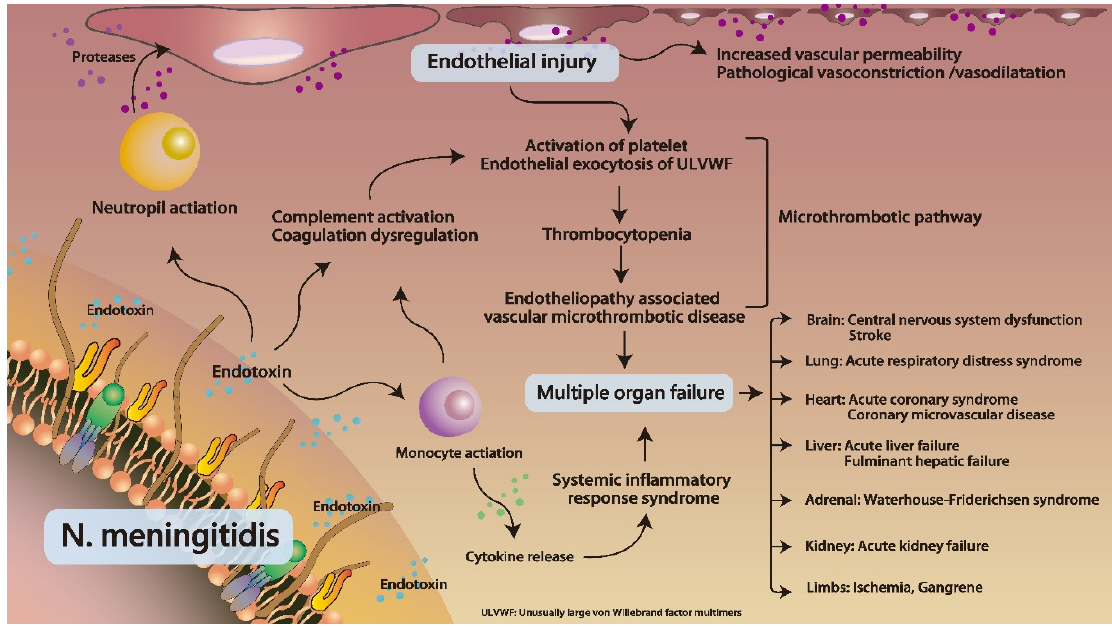
Figure 2. A schematic diagram illustrating the detailed pathophysiological mechanism between septicemia and disseminated intravascular coagulation in Neisseria meningitidis infection. Adapted from Chang [14,15] and Pathan et al. [13].